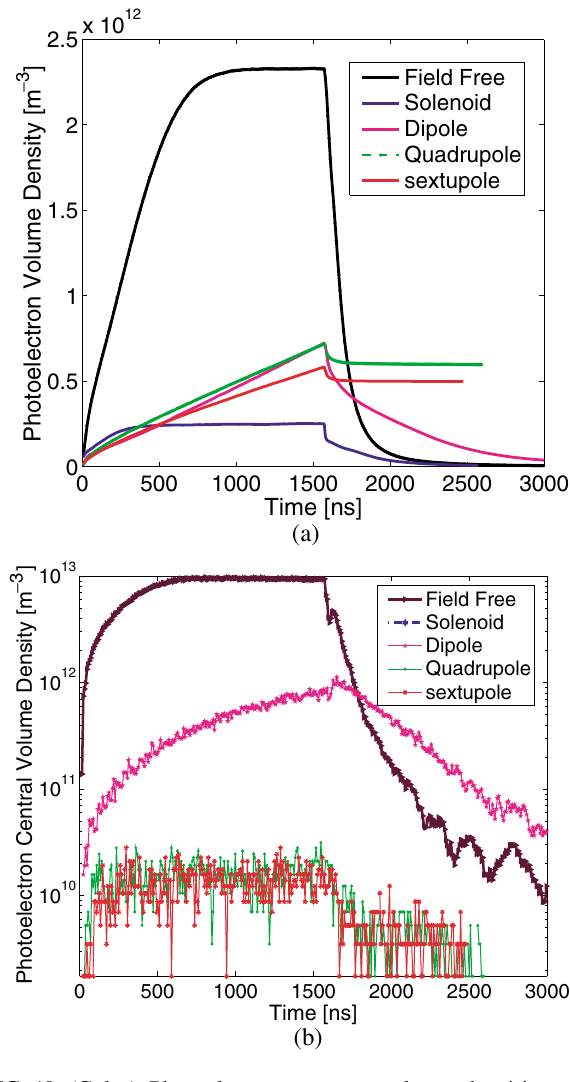
FIG. 18. (Color) Photoelectron average volume densities and volume densities at pipe center in a different magnet field as a function of time for a train with 200 bunches spaced by 7.86 ns and followed by a long bunch train gap. (a) Average volume densities; (b) volume densities at pipe